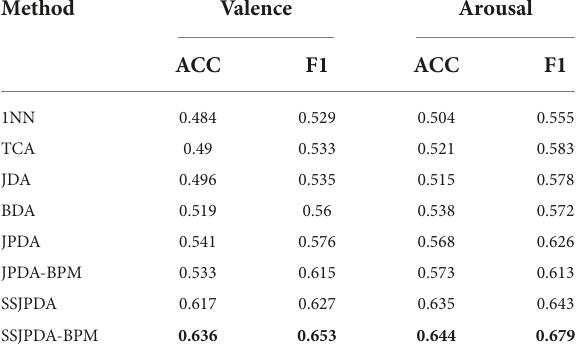
TABLE 3 The average accuracy and F1-measure of different algorithms in valence and arousal classification.